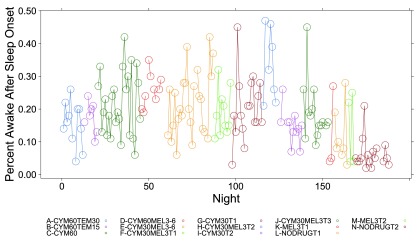
Percent time awake after sleep onset.The percent time subject was awake during 5-minute intervals detected by the Zeo Sleep Monitor throughout the entire study. Dosages of Cymbalta (CYM60 = 60 mg, CYM30 = 30 mg), temazepam (TEM30 = 30 mg, TEM15 = 15 mg) and melatonin (MEL3 = 3 mg, MEL6 = 6 mg) were varied according to combinations A-N (T1, T2, T3 are trial replicates), including no drug trials (L, N).